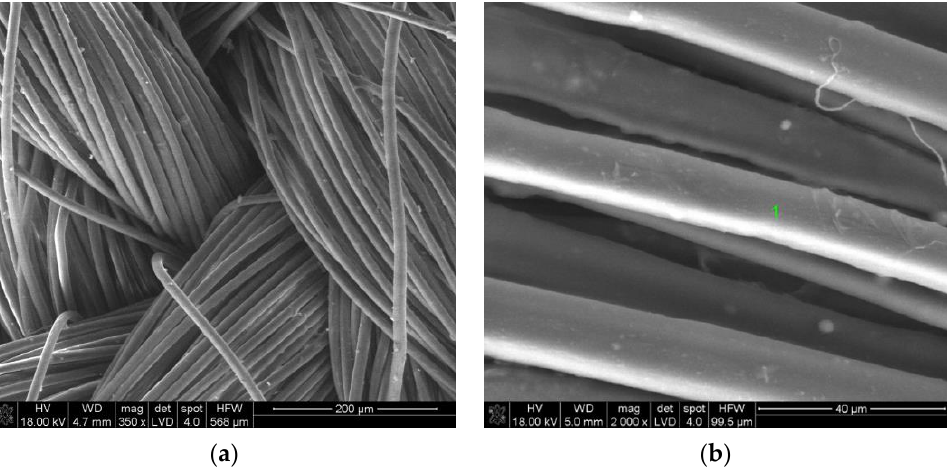
Figure 8. SEM image of Ti-Si coated NATAN fabric at magnification of ( a ) 350×; ( b ) 2000×; point “1” is marked for EDS analysis.